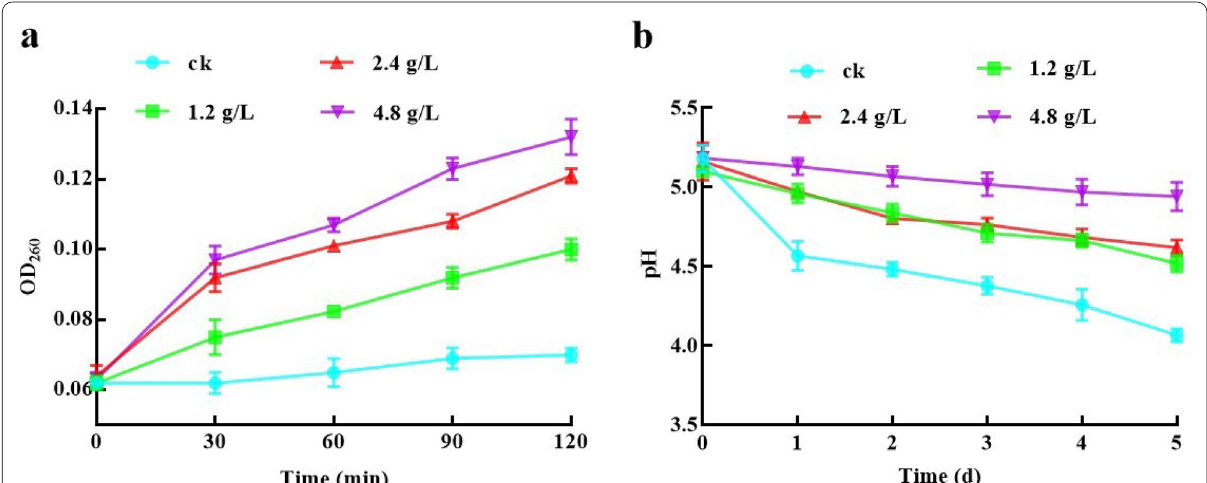
Fig. 5 Effects of X33 AMOP treatment on growth status of P. digitatum . a X33 AMOP promotes the release of cellular constituents . b Inhibitory effect of the X33 AMOP on glucose-dependent acidification of medium in P. digitatum . Water cycle represents the control group treated by ultrapure water. Green square represents the treatment group incubated with 1.2 g/L of X33 AMOP. Red upper triangle represents the treatment group incubated with 2.4 g/L of X33 AMOP. Purple lower triangle represents the treatment group incubated with 4.8 g/L of X33 AMOP